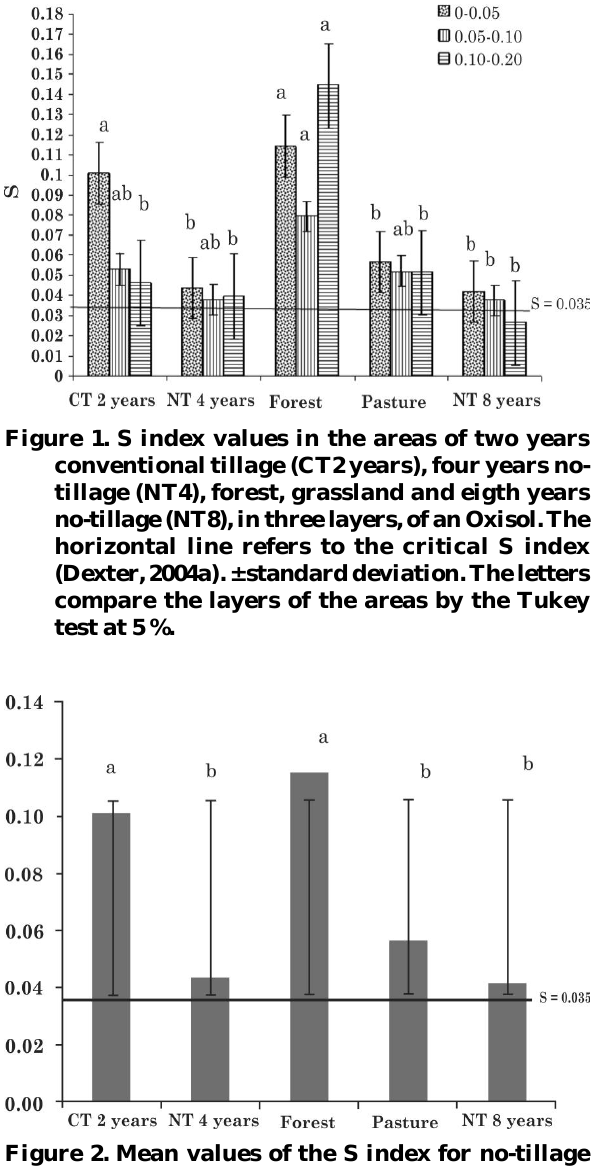
Figure 2. Mean values of the S index for no-tillage areas for two years (CT2) no-tillage for four years (NT4) no-tillage for eight years (NT8), and pasture and native vegetation, soil. The horizontal line refers to the critical S index (Dexter, 2004). ± standard deviation. The letters compare areas by the Tukey test at 5 %.